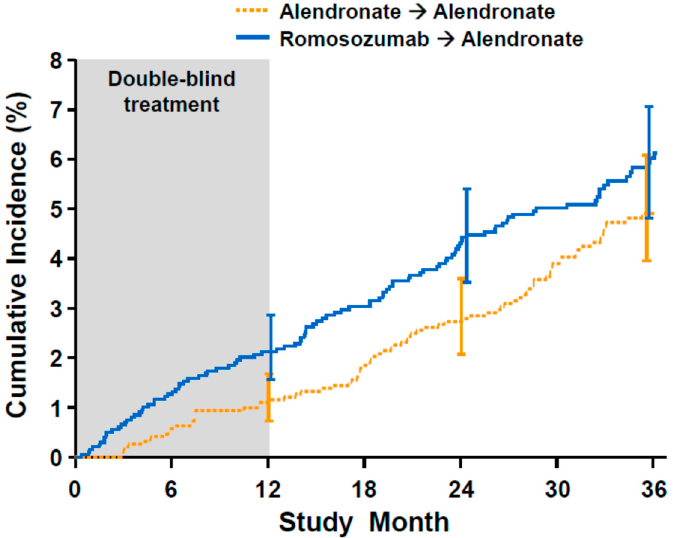
Figure 1. Time to first cardiovascular event in ARCH (romosozumab vs. alendronate), according to study arm. Note the absence of cardiovascular events in the first three months in the alendronate arm (source: FDA website [83], free for reproduction).